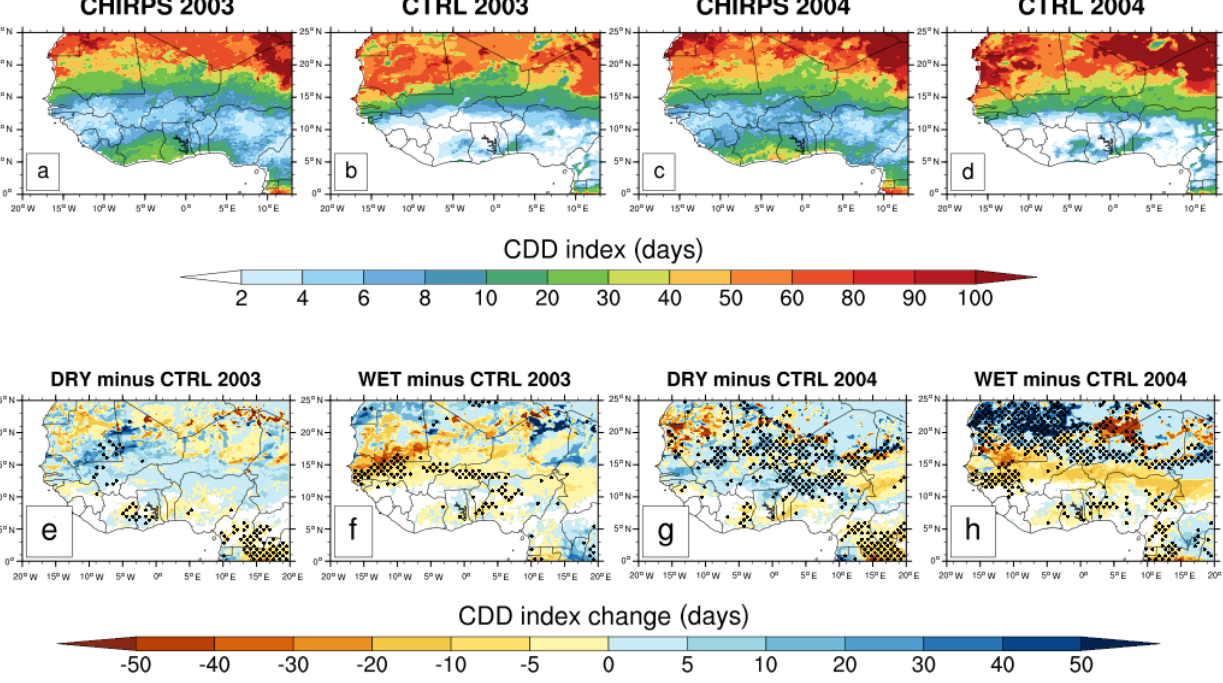
CWD length of more than 20 d is found over the mountain regions, such as the Cameroon Mountains, Jos Plateau and Guinea Highlands, whereas a minimum CWD length of less than 4 d is found over most of the area above 17 ◦ N latitude (Fig. 8a,